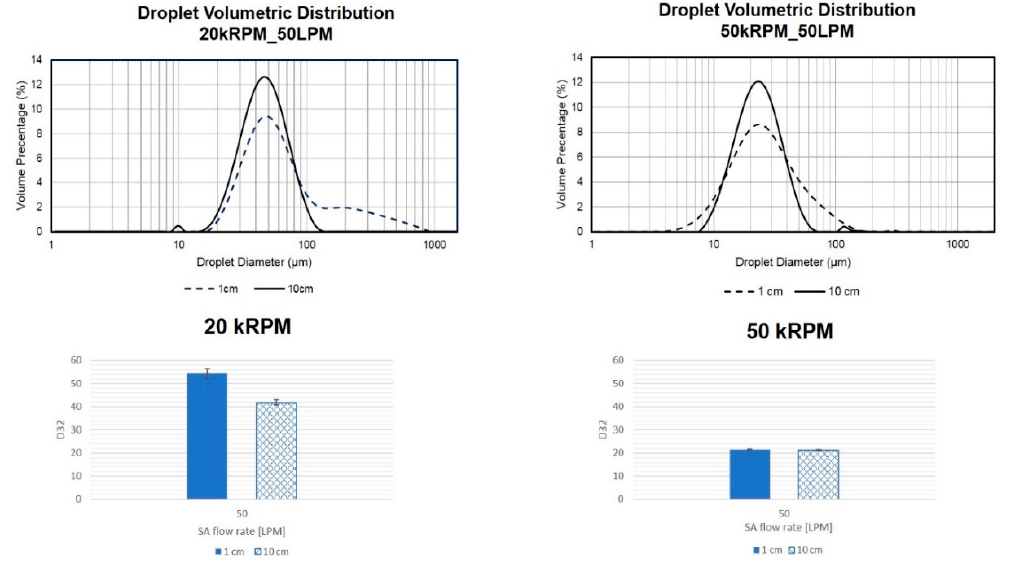
Figure 5. Droplet volumetric distribution versus droplet diameter and Sauter Mean Diameter at 1 and 10 cm downstream of the cup as the bell cup rotary speed was changed from 20,000–50,000 RPM (liquid flow rate was 0.1 LPM, and SA flow rate was 50 LPM).